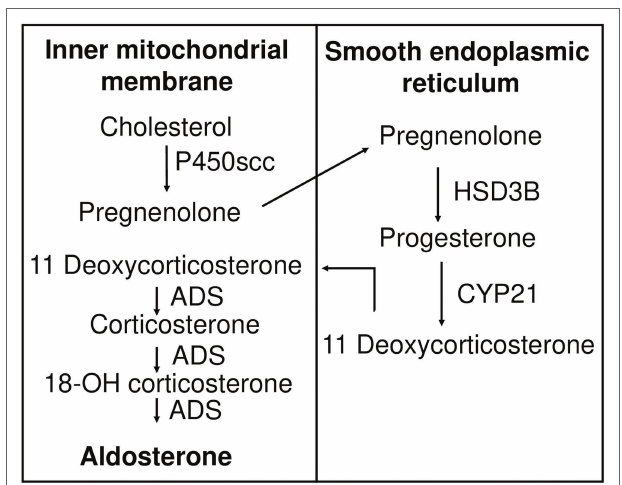
FIGURE 2 | Aldosterone biosynthesis pathway. Cholesterol is transported to the inner mitochondrial membrane, where it is hydroxylated and cleaved by cytochrome P450scc to produce pregnenolone. Pregnenolone is relocated to the membrane of smooth endoplasmic reticulum, where it is oxidized by HSB3D to produce progesterone. Eleven deoxycorticosterone is generated by CYP21-mediated hydroxylation of progesterone and moves back to the inner mitochondrial membrane, where it is subject to ADS-catalyzed sequential 11-hydroxylation, 18-hydroxylation, and 18-oxidation, producing corticosterone, 18-OH corticosterone, and finally aldosterone, respectively. P450scc, cytochrome P450 side chain cleavage enzyme; HSD3B, 3 β -hydroxysteroid dehydrogenase; CYP 21, 21 hydroxylase; ADS, aldosterone